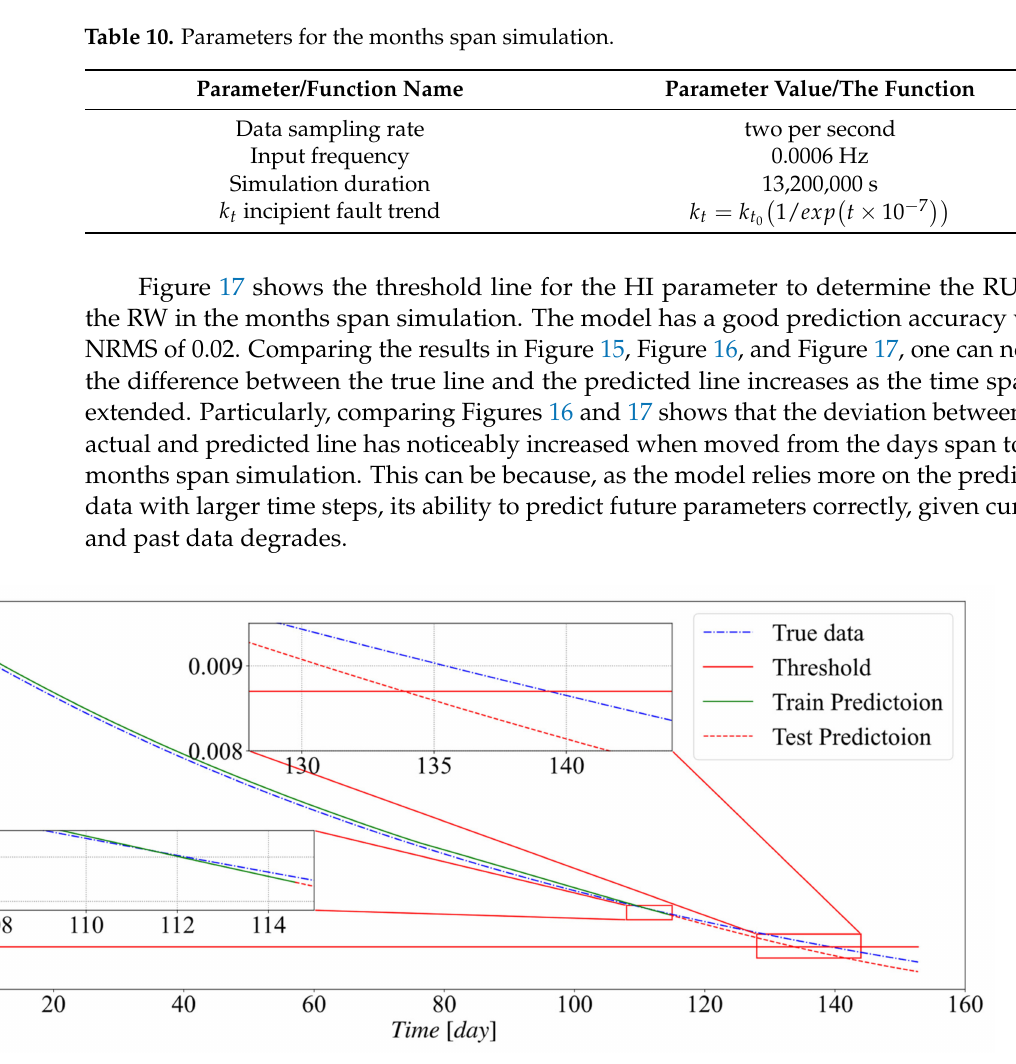
Figure 17. Predicted HI parameter and RUL for months